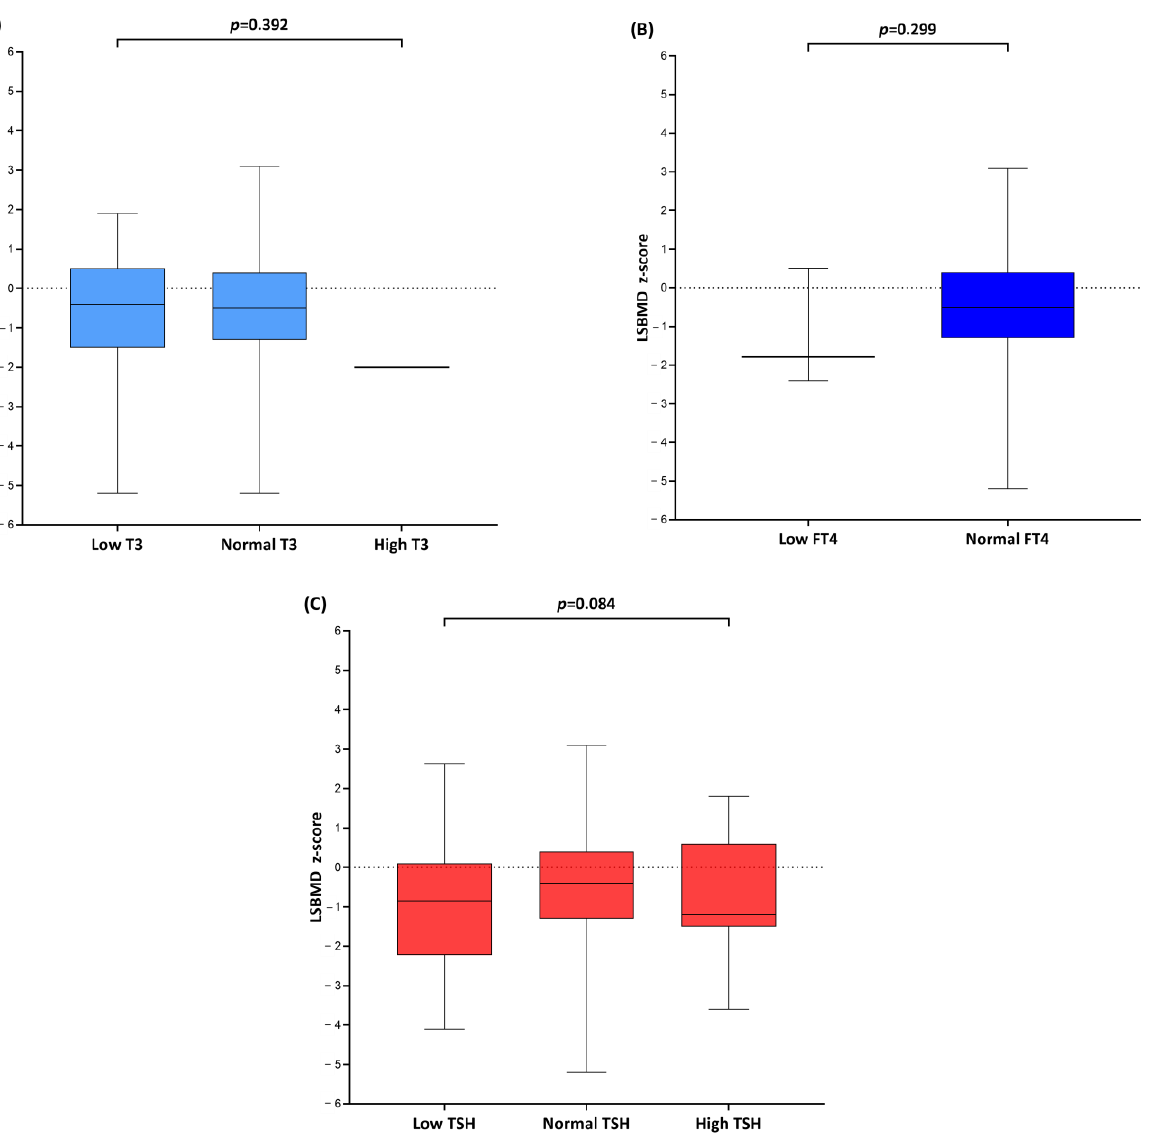
Figure 2. Box-and-whisker plots were drawn to compare lumbar spine bone mineral density (LSBMD) z-scores when ( A ) triiodothyronine (T3), ( B ) free thyroxine (FT4), and ( C ) thyrotropin (TSH) levels were low, normal, or high. The lines inside the boxes indicate the mean value while the whiskers represent the lowest and highest observations, respectively. * No subjects with high FT4. Table 2. The comparison of bone mineral density z-scores when triiodothyronine, free thyroxine, and thyrotropin levels were normal and abnormal.